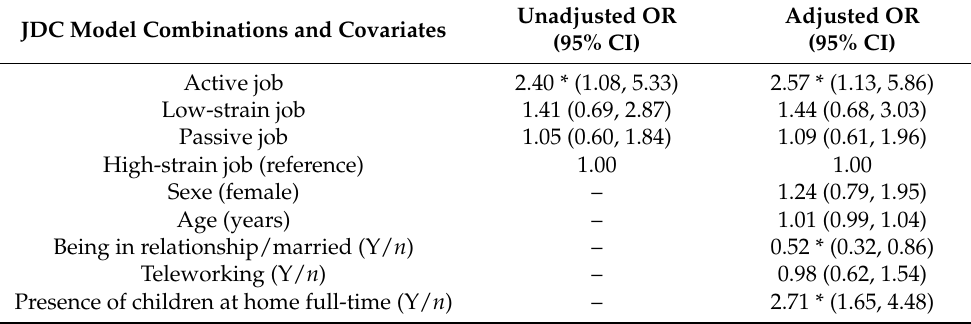
Table 2. Unadjusted and covariate-adjusted odds ratios for predictors of becoming physically active at T2 or T3 ( n = 440).